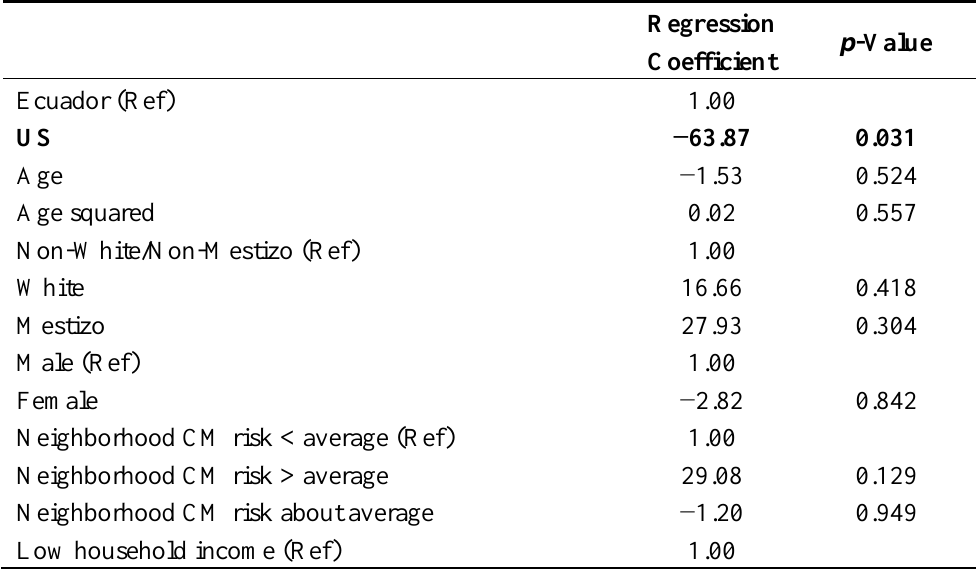
Table 3. Interval Regression Results of WTP for Reducing the Risk of CM Mortality by 1 in 100,000: Ecuador and the United States (N =